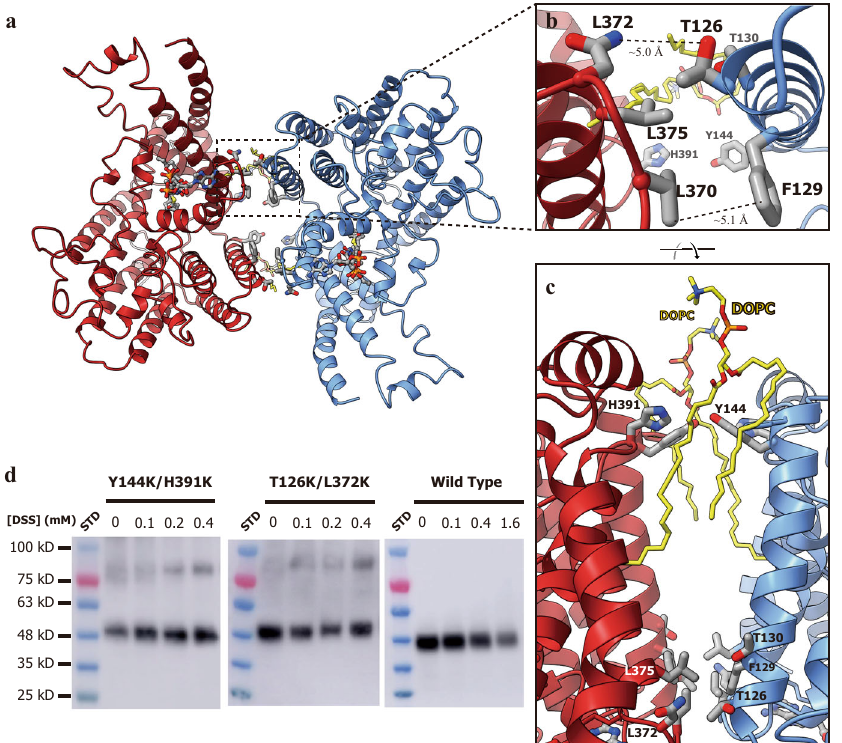
Fig. 6 The non-contact dimer of LPCAT3. a The molecular model of LPCAT3/araCoA viewed from the lumen side of the ER membrane. The residues and DOPC molecules at the non-contact dimeric interface, as well as the araCoA molecules, were shown as stick model. b , c A close view of the dimeric interface at two angles. d The crosslinking assay on membrane-bound cLPCAT3. The wild type cLPCAT3 and the double mutants of the dimeric interface, T126K/L372K and Y144K and H391K, were treated with the crosslinking reagents DSS at the concentrations as indicated before solubilized from the membranes of the Expi293 cells overexpressing the corresponding proteins. Shown were the representative results from three independent